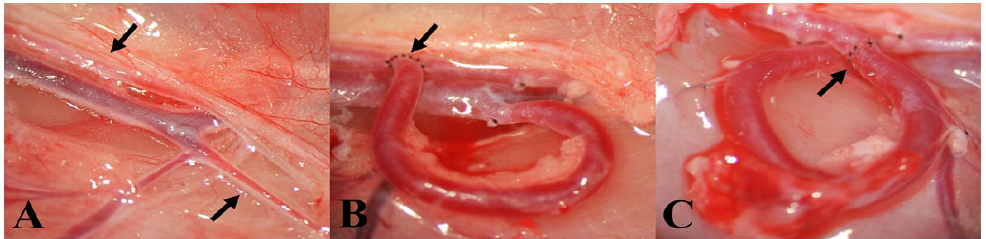
Figure 1. Photos of the vessels and the operation. ( A ) The dissected vessels. The top arrow shows the femoral artery, while the bottom arrow points to the superficial inferior epigastric vein (SIEV). ( B ) The finished arterio-venous fistula. The arrow shows the end-to-side anastomosis between the femoral artery and the SIEV. ( C ) The loop-shaped SIEV graft interpositioned into the femoral artery. The arrow points to the proximal anastomosis. Magnification: 10×.